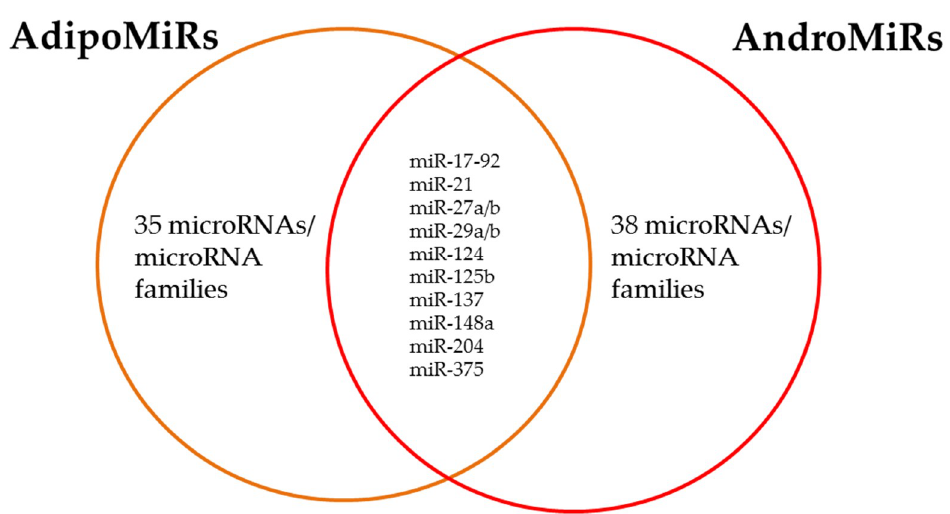
Figure 2. Putative overlap of microRNAs identified as adipogenesis-related or androgen-regulated so far.